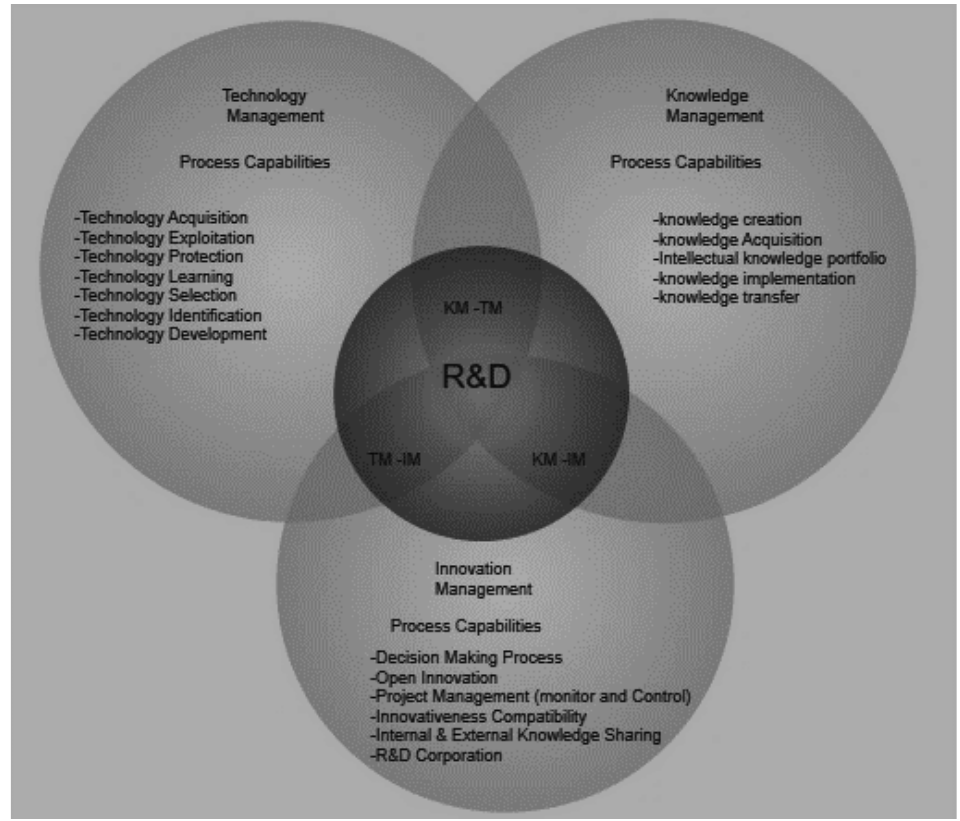
Figure 2. Detailed dimensions at capability frontiers related to SMD that influence R&D. Sources: [10,15,17,21]. Table 1. Dimensions and criteria. Dimensions